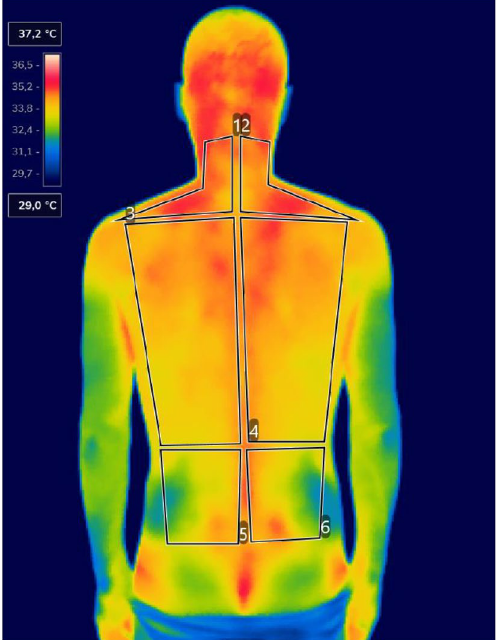
Figure 4. Representation of IRT acquisition and polygon division of each back’s area. Numbers 1 and 2 represent the cervical area, numbers 3 and 4 the dorsal area, numbers 5 and 6 the lumbar area. Thermogram edited with the software Thermal Studio PRO, version number: